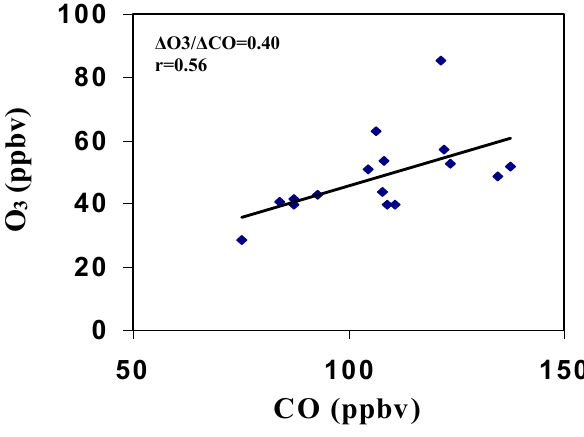
Fig. 10. Scatter plot of 681hPa O 3 versus CO in Region 1 for DJF4. as they were transported further east as suggested by the O 3 - CO slope of 0.49 mol mol − 1 , significant at the p = 0.01 level, for DJF1 in Region 3. This scenario is possible since the cy- clones of DJF1 often represent a later stage than cyclones of